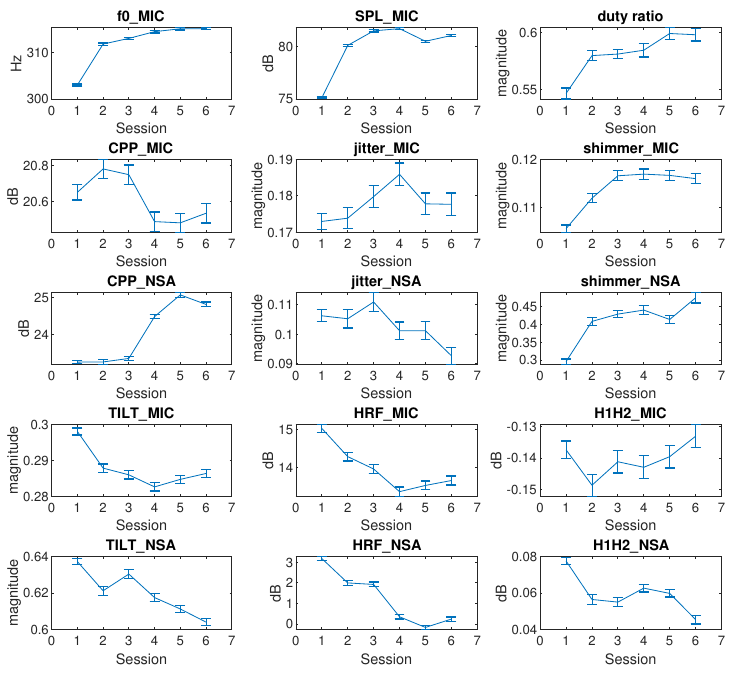
jitter_MIC increased rapidly from S1 to S4 by 10% but decreased by 5% afterwards, which was not well correlated with the subjective rating results for the VLT sessions. The jitter_NSA showed a trend similar to jitter_MIC, but with a larger decrease after S3. The mean values of the shimmer_MIC and shimmer_NSA were well correlated ( r = 0.91, p = 0.987). Their progressions were similar to that of the f 0. This indicates that the loudness perturbation increased rapidly in the early sessions, and saturated at a high level over the last sessions.